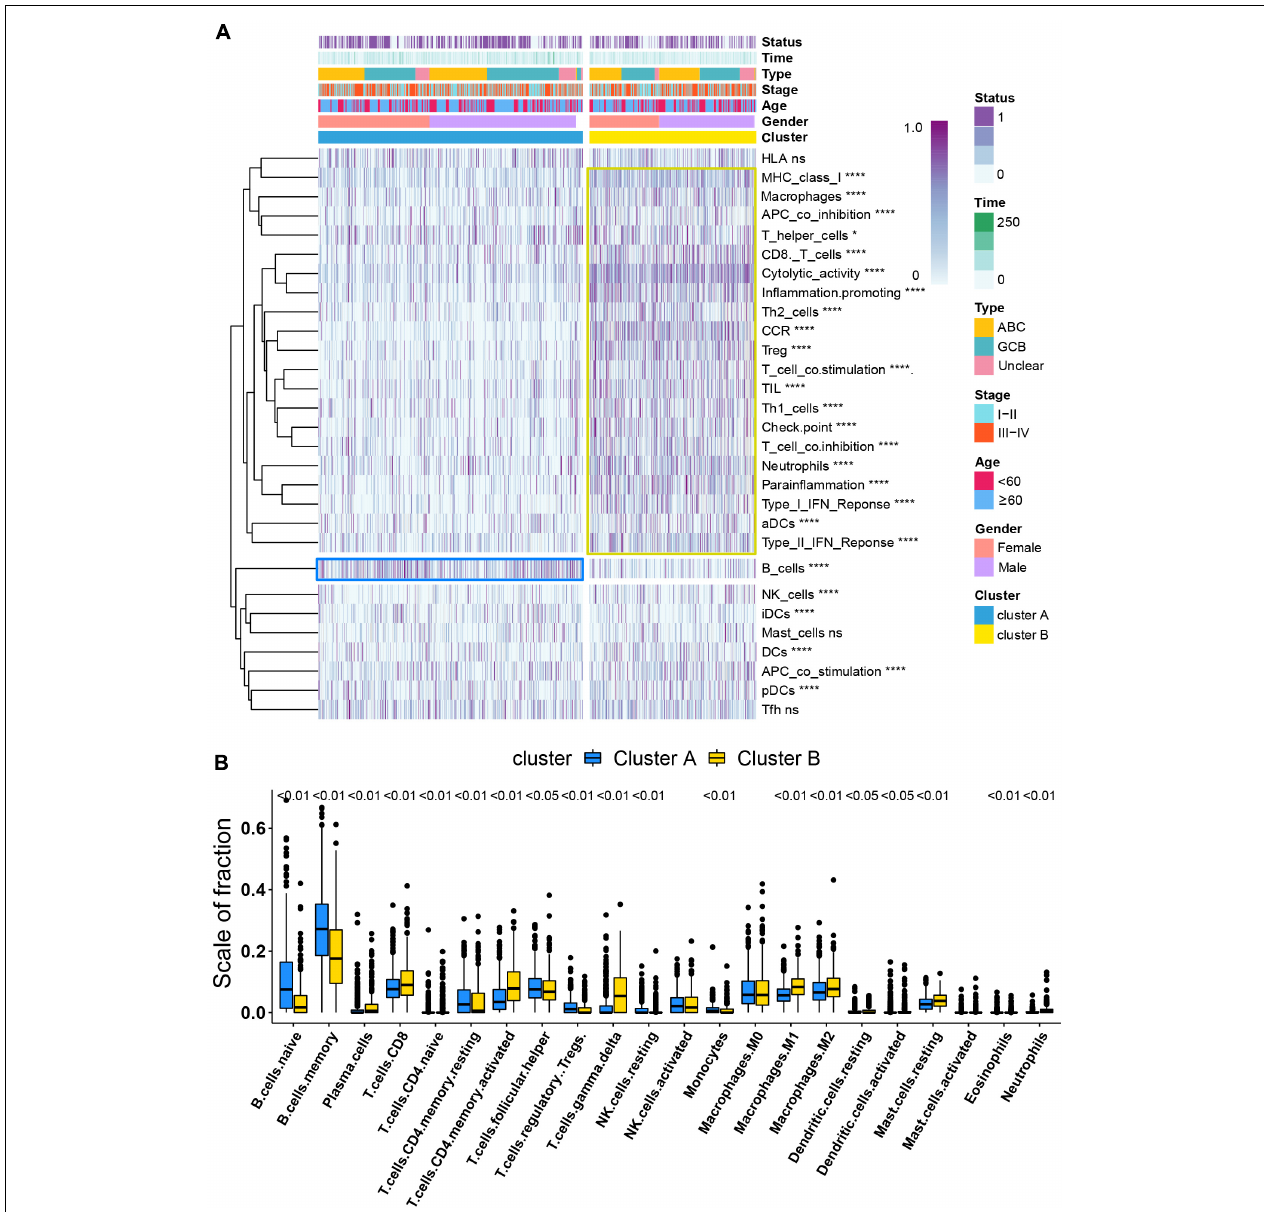
FIGURE 3 | Immune signature analysis. (A) Unsupervised hierarchical clustering of immune cell types and functions by individual subtypes (cluster A, blue; cluster B, yellow. * P < 0.05; ** P < 0.01; *** P < 0.001; and **** P < 0.0001). (B) Comparative fraction of the immune cell infiltration between cluster A and cluster B subtypes.